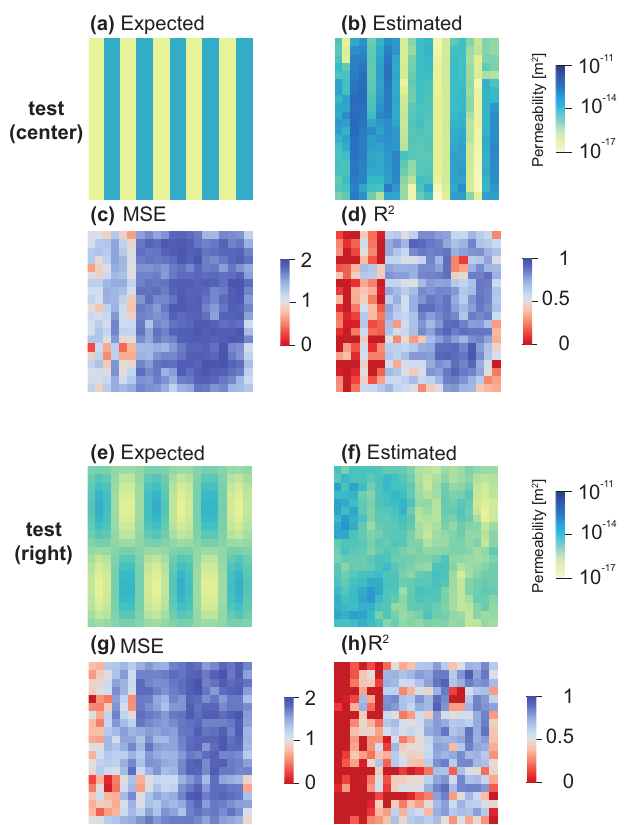
Figure 9. Estimation accuracy in the case of different source locations from the training data. ( a ) Ex- pected vs. ( b ) estimated values, and spatial distributions of ( c ) MSE and ( d ) R 2 when the heat source was located at the bottom center. ( e ) Expected vs. ( f ) estimated values, and spatial distributions of ( g ) MSE and ( h ) R 2 when the heat source was located at the bottom